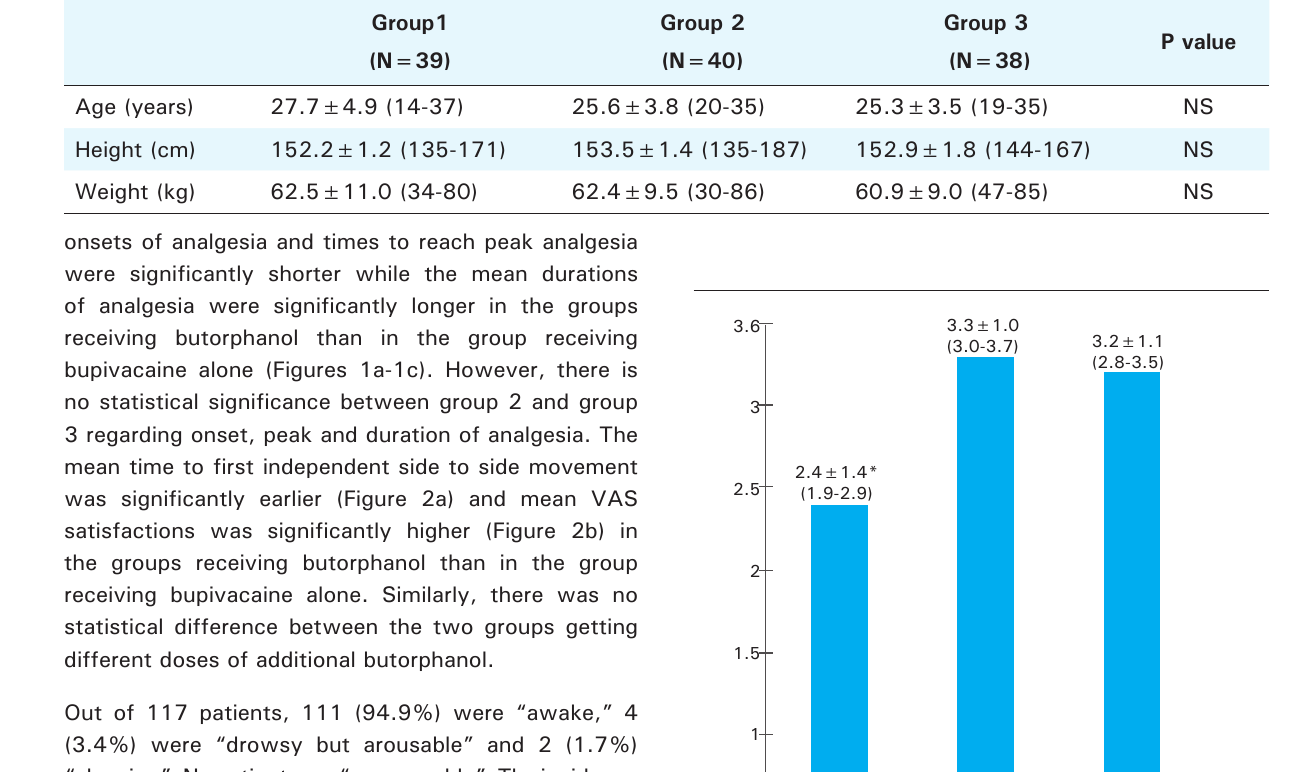
table 1. Demographic Profiles of the Patients